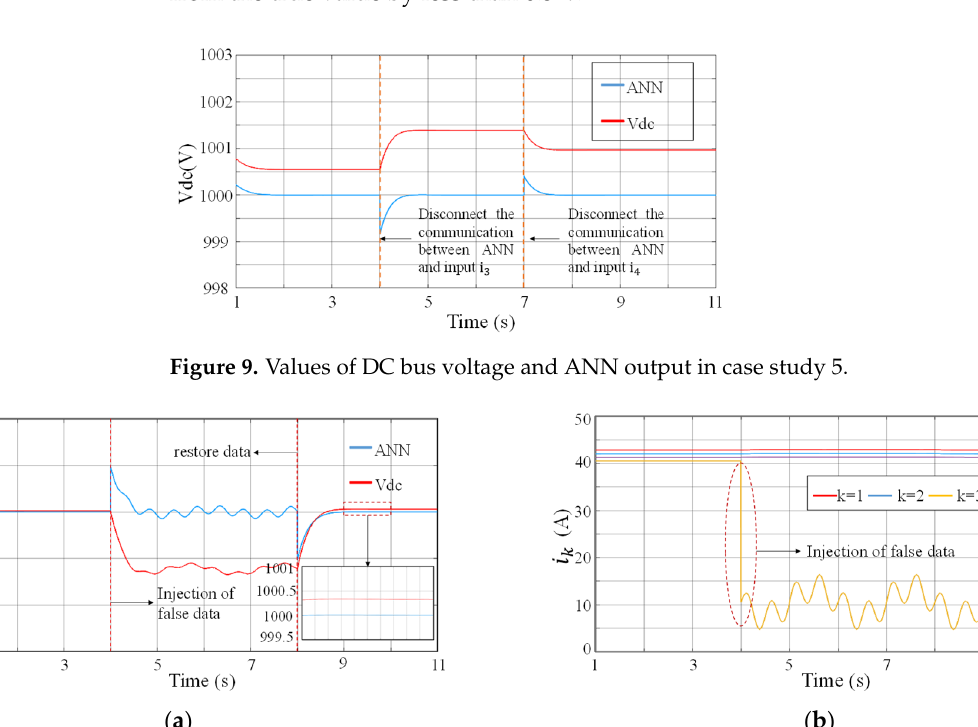
( b ) Figure 8. ( a ) Values of DC bus voltage and ANN output in case study 4; ( b ) Values of currents of the bidirectional DC ‐ DC converters in case study 4.